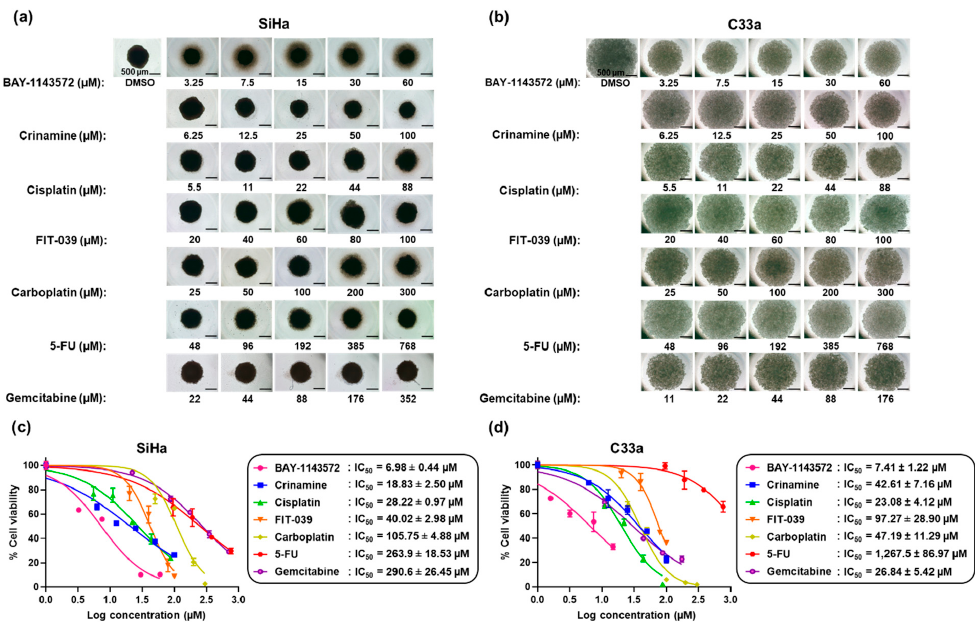
Figure 2. Comparative cytotoxicity of CDK9 inhibitors, chemotherapeutic drugs, and crinamine in a three-dimensional multicellular tumor spheroid culture. ( a , b ) MCTS morphology of ( a ) SiHa and ( b ) C33a tumor spheroids grown for seven days followed by 2-day treatment at the indicated concentrations of BAY-1143572, crinamine, cisplatin, FIT-039, carboplatin, 5-FU, gemcitabine, or DMSO. ( c , d ) Dose-response plots for ( c ) SiHa and ( d ) C33a tumor spheroids after treatment with various concentrations of di ff erent compounds. Cell viability was assayed and normalized to the DMSO control. IC 50 values were calculated from two independent experiments performed in duplicate or triplicate and are presented as the mean ±